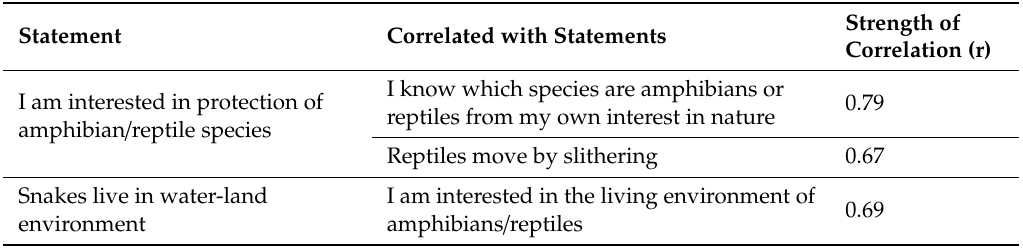
Table 4. Correlation between concepts and alternative conceptions about amphibians and reptiles from question 7 of the questionnaire in connection with answers to other